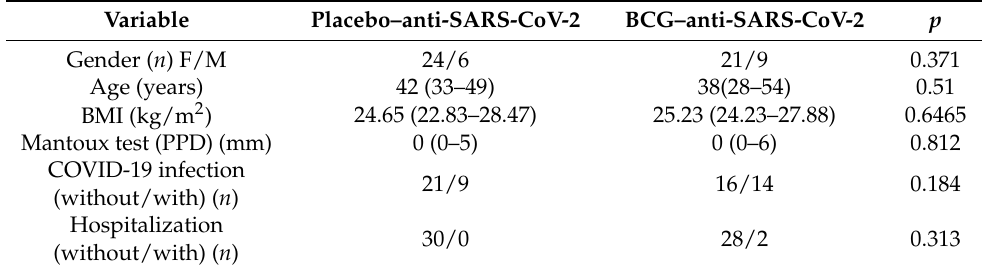
Table 2. Comparison between experimental